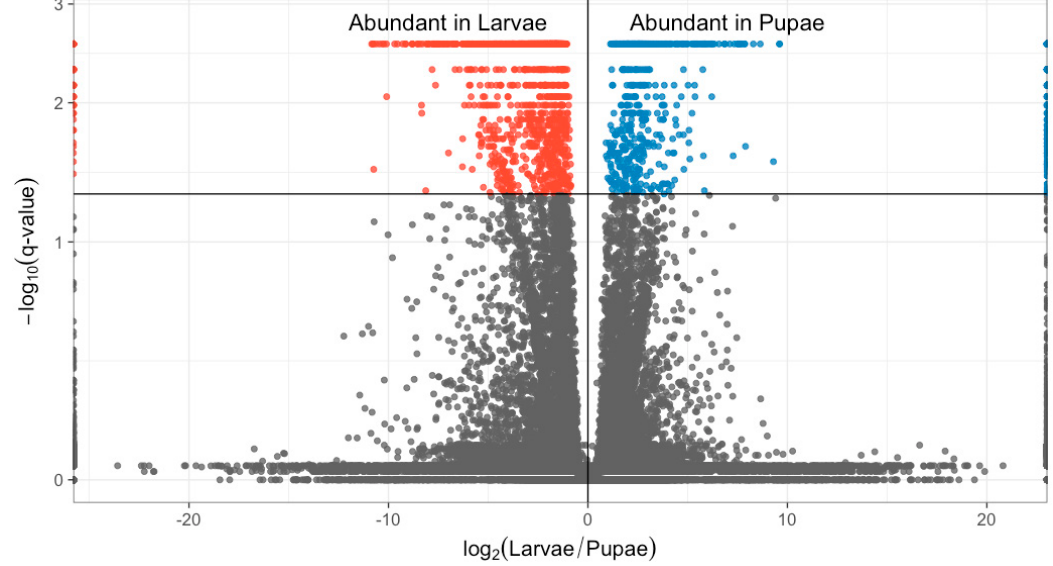
Figure 2. Visualization of transcript expression: data relating to differentially expressed transcripts are shown in red and blue, non-differentially expressed transcripts in black. Volcano plot displays the relationship between fold change and q -values.